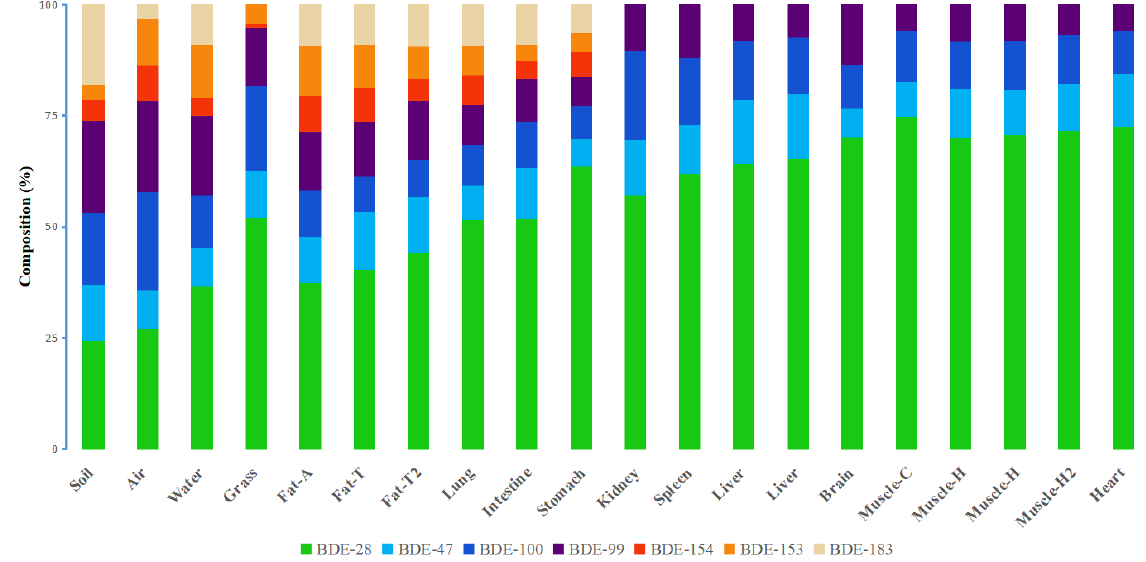
Figure 2. Polybrominated diphenyl ether congener patterns for the different tissues or organs from a sheep raised in a remote grassland area. Notes: Fat-A = abdominal fat, Fat-T = tail fat, Fat-T2 = tail fat of the second sheep, Muscle-C = chest muscle, Muscle-H = hind leg muscle, Muscle-H2 = hind leg muscle of the second sheep.